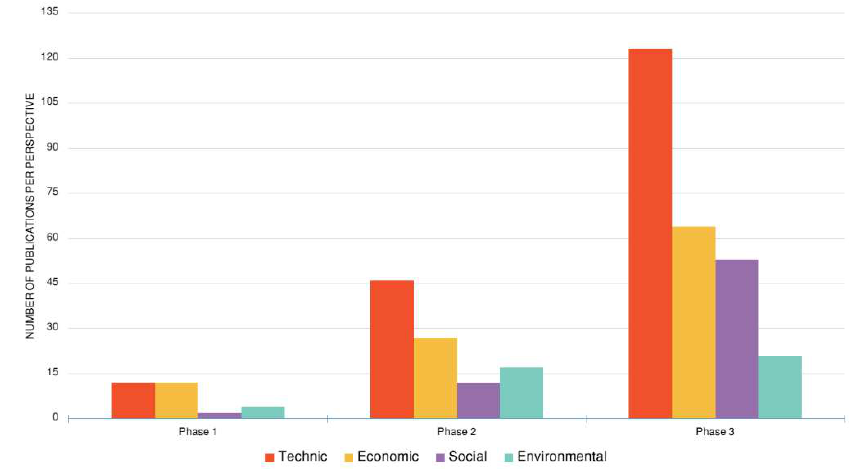
Figure 13. The number of each perspective in peer-reviewed publications between 1982 and 2016.